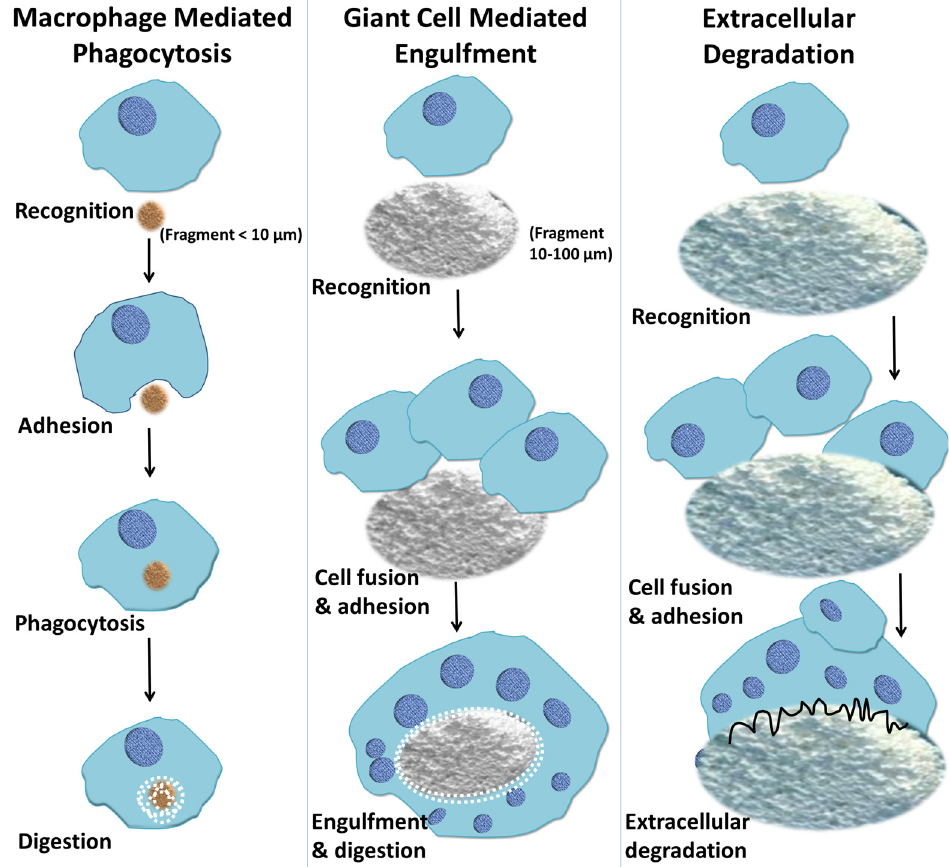
Figure 5. A schematic depiction of macrophage response to biomaterials depending on the size of the implanted materials. Macrophages respond to small fragments and particles (<10 µ m in diameter) by internalization via phagocytosis and intracellular digestion. If the particle size is larger than 10 µ m and smaller than 100 µ m, the macrophages fuse together, forming giant cells which in turn engulf the particles and digest them. the particles are larger, the bulk digestion is carried out via extracellular degradation